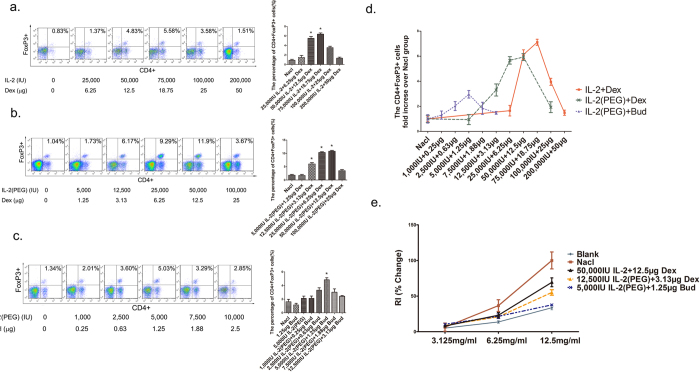
Treg cells and lung resistance analysis after administration of various drug combinations between glucocorticoids and IL-2.Female BALB/c mice were immunized with OVA i.p on days 1 and 8, followed by intranasal (i.n) 2% OVA challenges on days 9–14. Drugs were administrated intratracheally on days 12–14. On day 15, mice were sacrificed and analyzed. (a–c) Detection of CD4+FoxP3+ Treg cells after 3 days of treatment with different doses of IL-2 plus dexamethasone (Dex) (a), IL-2(PEG) plus Dex (b) and IL-2(PEG) plus budesonide (Bud) (c) in asthma model mice with a fixed ratio between two drugs (40,000 IU IL-2: 1 μg glucocorticoid). The upregulation of Treg cells was dose-dependent and different dosage forms could upregulate Treg cells and alleviate asthma in various doses. (d) Synthetic analysis of the upregulation of Treg cells in three dosage forms. (e) AHR analysis between treated and untreated mice. Results represent the changes in lung resistance (Rl) as a measure of AHR. *p < 0.05. (a–c) Data are presented as means ± SEM (n = 8 per group and data point). Treated group versus untreated group by Student’s t test. (e) Data are presented as means ± SEM (n ≥ 4 per group and data point); here representative results from 1 of 2 experiments are shown. Treated group versus blank group by Student’s t test. Blank group, health control mice. Nacl group, asthma model mice treated with normal saline.